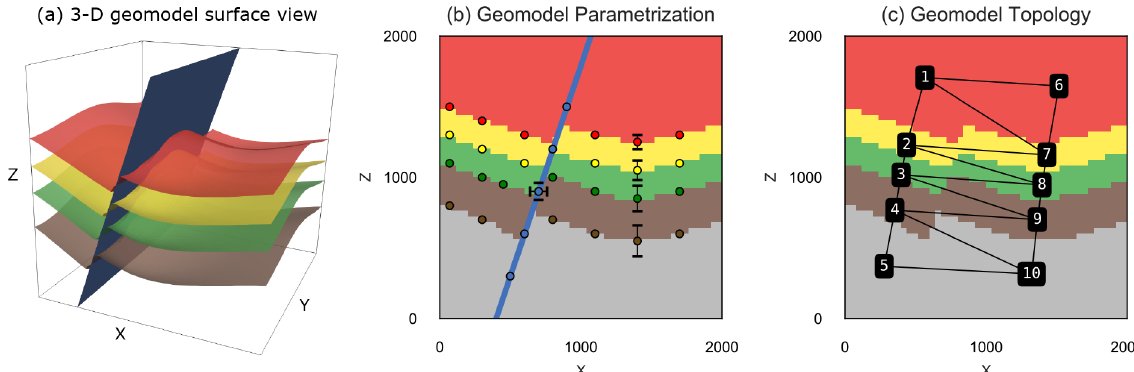
Figure 4. (a) 3-D view of the synthetic fault model, with top surfaces of the four lithologies shown and the fault surface in blue. (b) X–Z slice through the center of the discretized model showing partial input data (for visual brevity) and example standard deviations of prior parameters used for the stochastic simulation. (c) Model overlaid with its topology graph used as our summary statistic for the